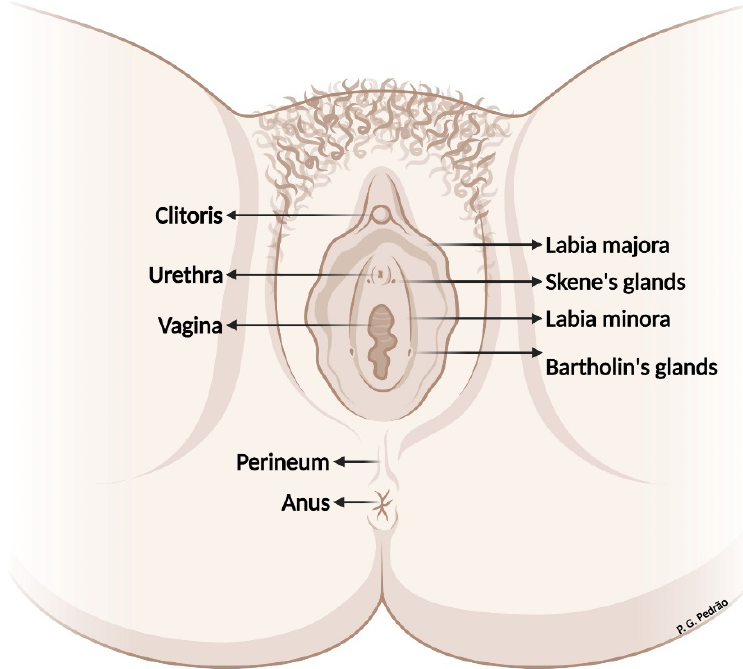
Figure 1. Vulvar anatomy.